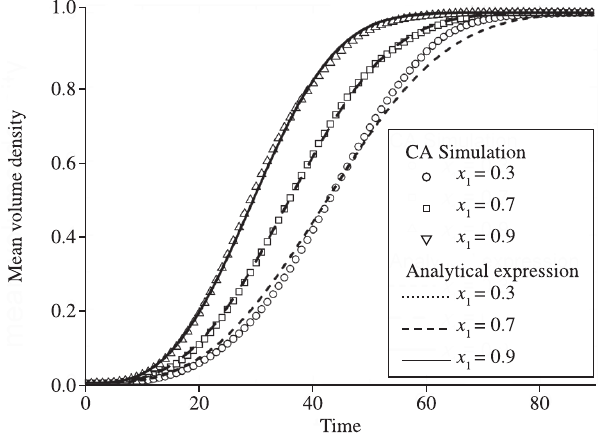
Figure 7. Microstructural path: area of the interface between transformed and untransformed regions per unit of volume, S There is good agreement between theory and simulation.